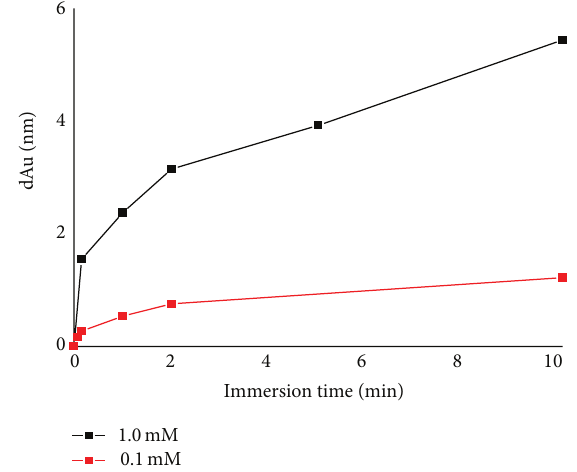
Figure 5: Growth of Au thin films when GaAs (100) sample is immersed in two different concentrations of HAuCl 4